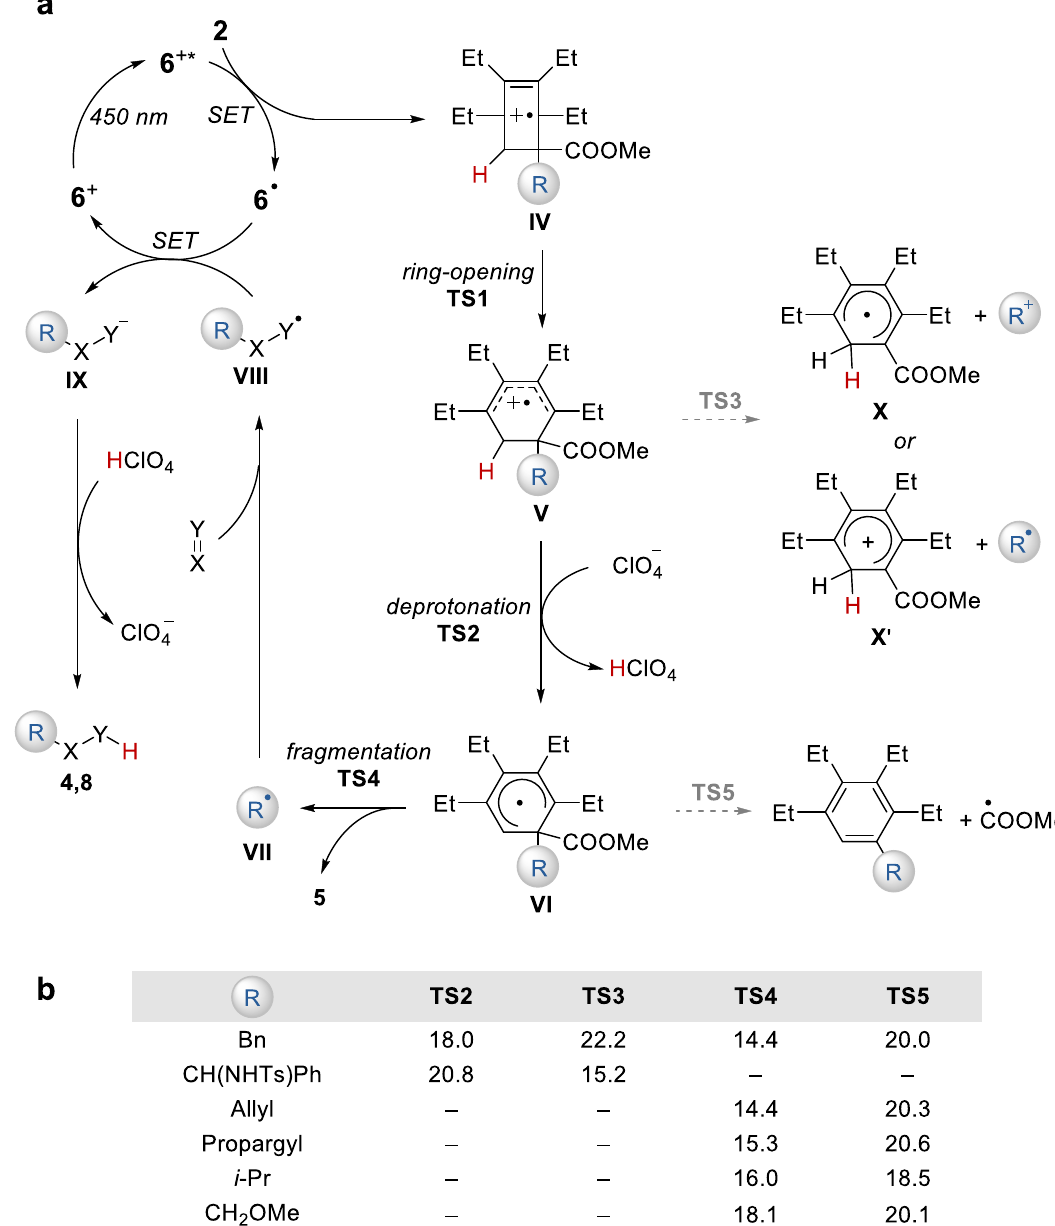
Fig. 4 Mechanistic hypothesis and DFT study of the aromatization process. a Proposed mechanism of alkyl transfer reaction of alkylated BCHs. b Selected DFT calculations for competing pathways. Computed at the SMD(DCM)/UM06-2X/def2-TZVPP//SMD(DCM)/UB3LYP/6-31 + G(d,p) level for TS2 and TS3 . Computed at the SMD(DCM)/UM06-2X/def2-TZVPP//UB3LYP/6-31 + G(d,p) level for TS4 and TS5 . To simplify our calculations, the ethyl groups and tolylsulfonyl group are replaced by methyl groups and methylsulfonyl group, respectively. Energy in